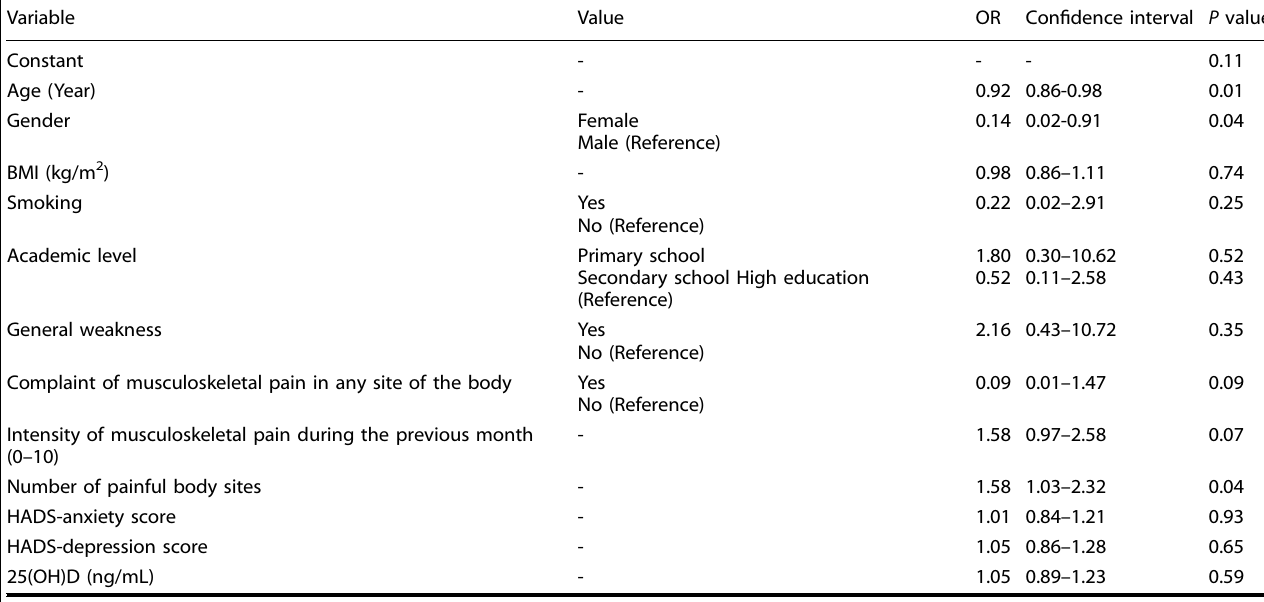
Table 4. Association between level of asthma control and other study